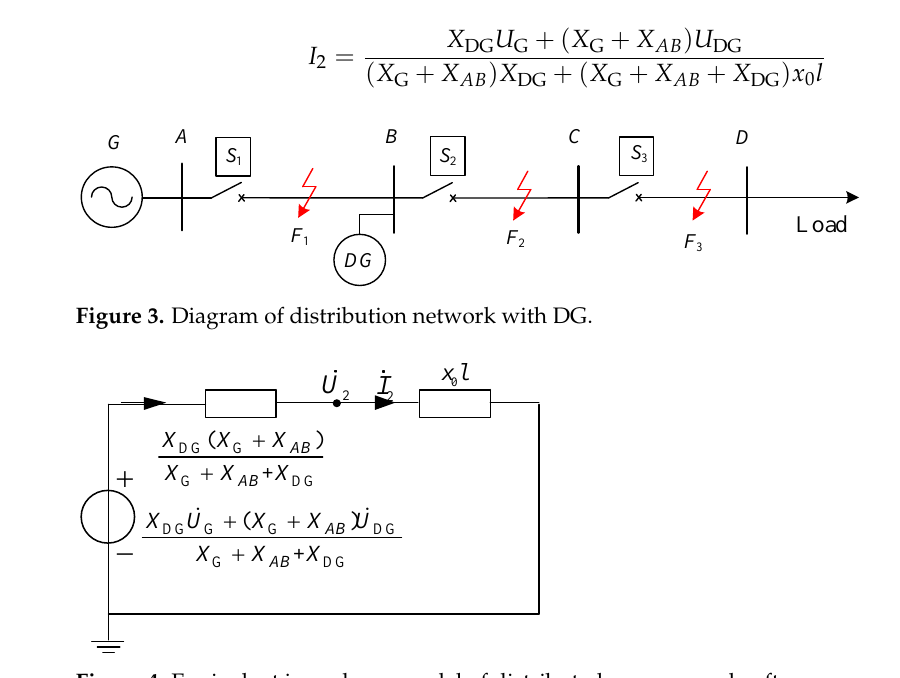
Figure 4. Equivalent impedance model of distributed power supply after access.